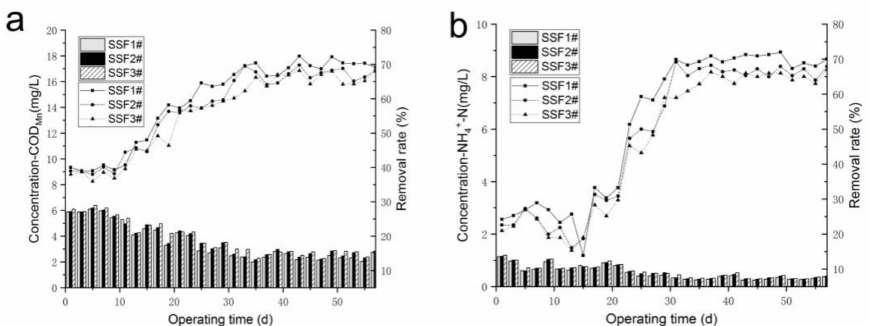
Figure 3. Relationship between different particle sizes and removal rate. ( a ) COD Mn . ( b ) Ammo- nia